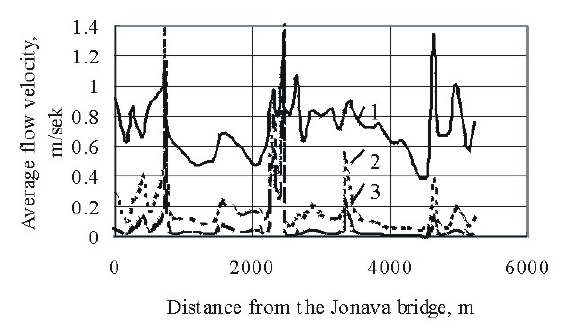
Fig. 4. Flow velocities: 1 – when flood discharge is 70 m 3 /s; 2 – when discharge is a normal 3 m 3 /s; 3 – when environmental discharge is 0.6 m 3